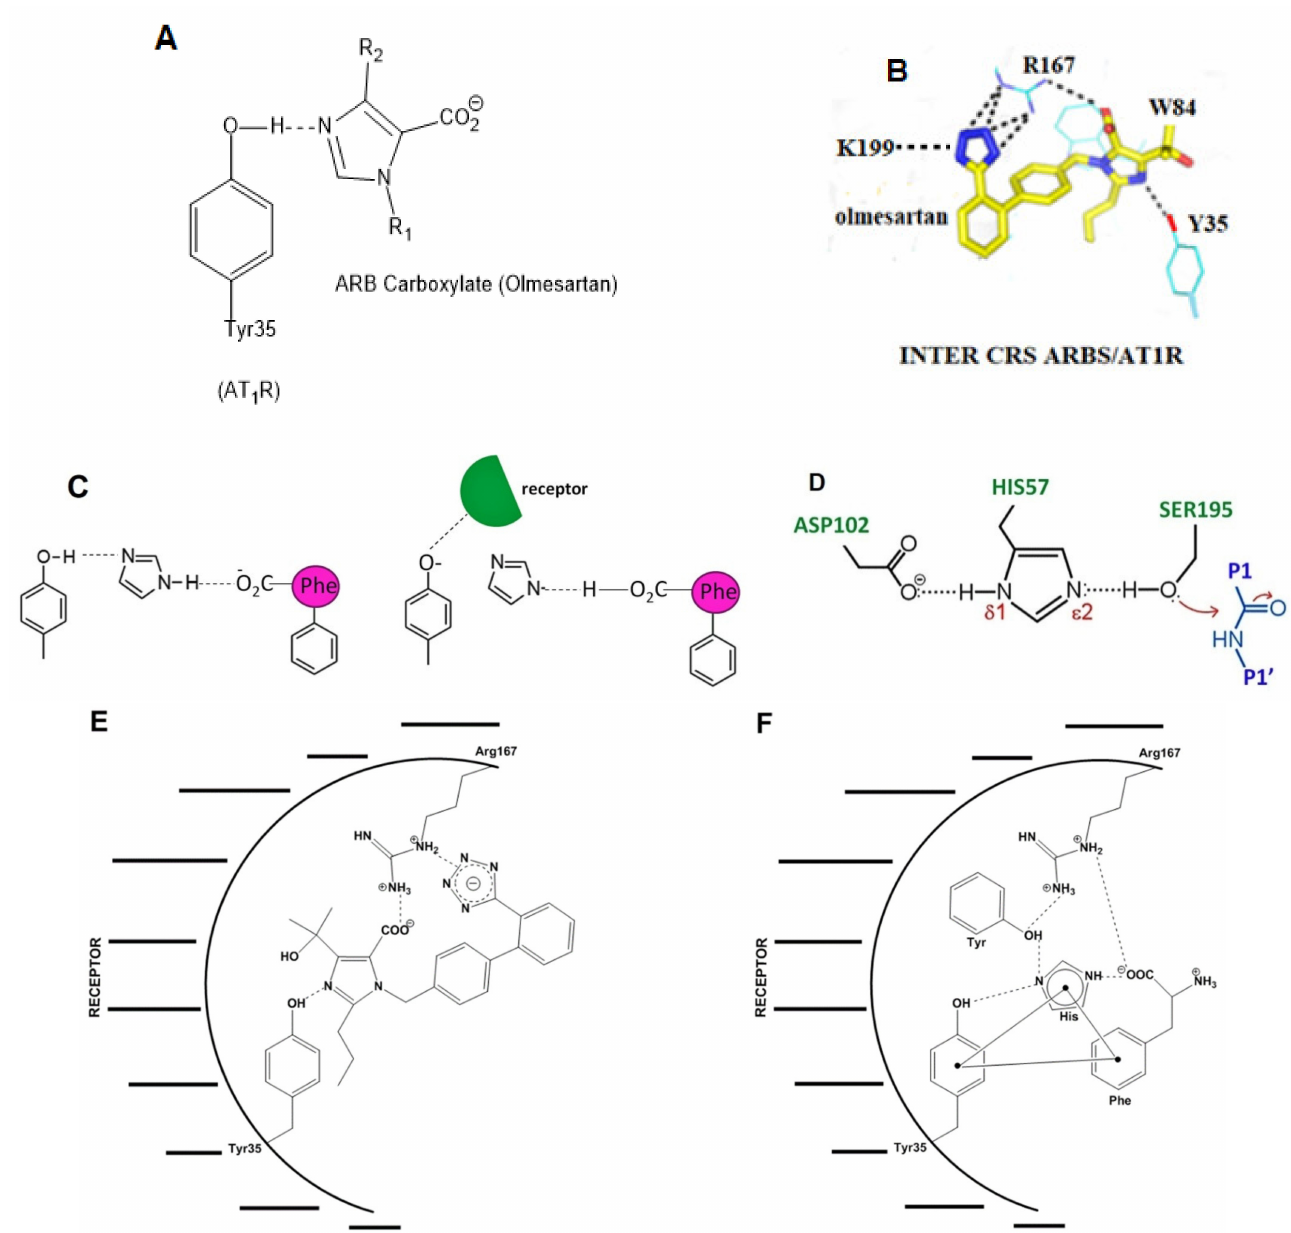
Figure 10. Intermolecular interactions between AT 1 R and the ARB, Olmesartan. ( A ) Explanatory graph depicting the hydrogen bond interaction between AT 1 R Tyr35 hydroxyl with Olmesartan imidazole nitrogen. ( B ) Interactions of AT 1 R residues K199, R167, W84, Y35 with olmesartan from crystal protein bank [45,46]. Note. ARBs may be inhibitors of SARS-CoV-2 and ACE2 binding through strong interactions between negatively charged tetrazolate and carboxylate with polybasic arginines cavity loop 681–686 S protein RBD of SARS-CoV-2. ( C ) Tyrosine (Tyr), histidine (His), and